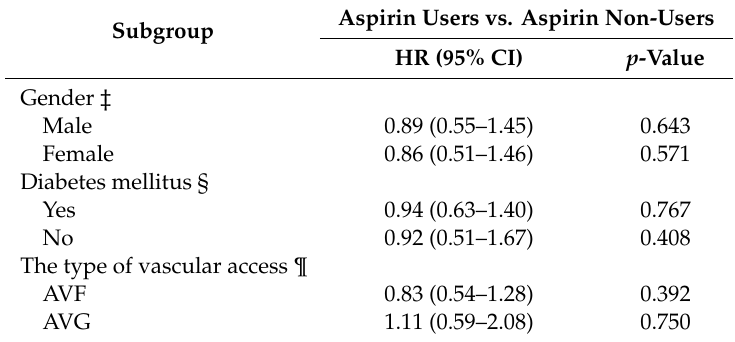
Table 3. Multivariate Cox proportional regression analysis for vascular access failure event (primary outcome) in each stratified group †.